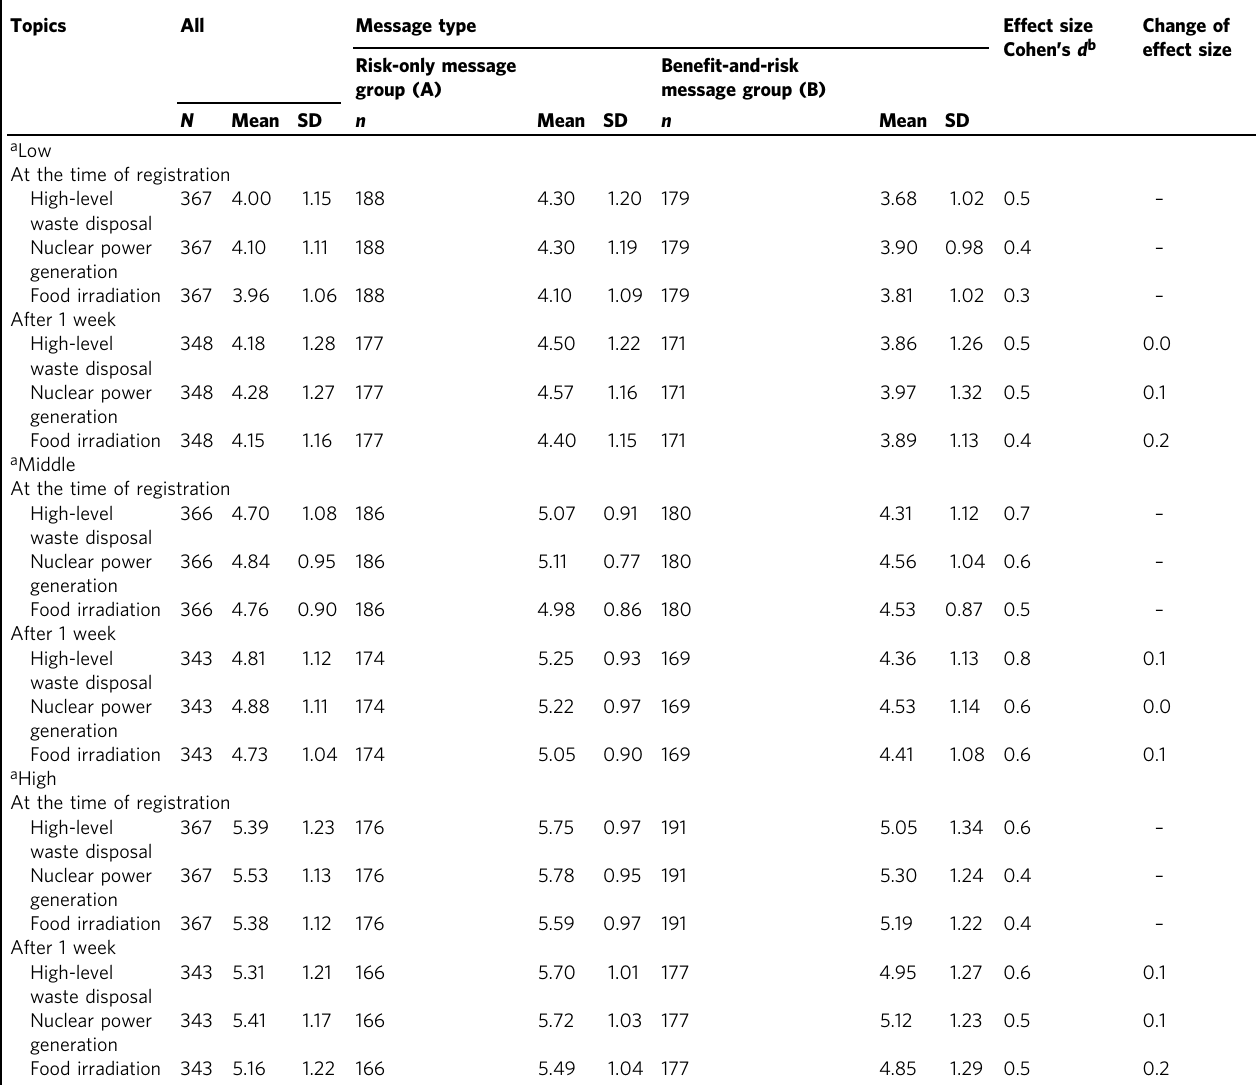
Table 3 Trust level in public agency strati fi ed by the level at the baseline.